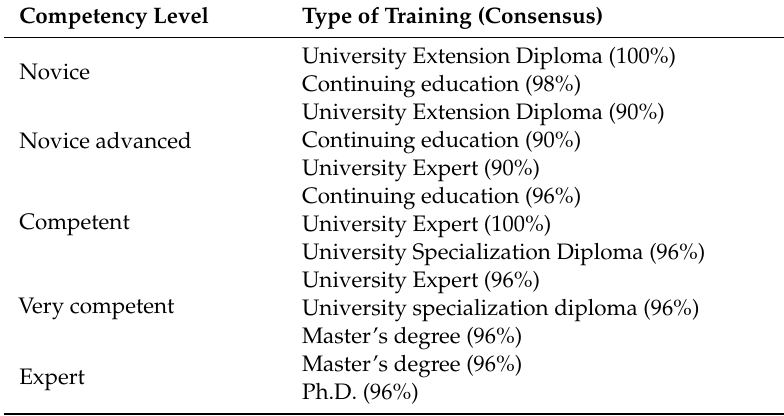
Table 4. Training required by competency level.